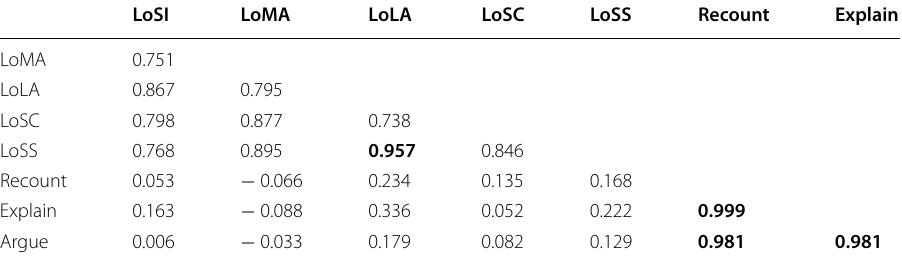
Correlations higher than 0.90 are bolded. The proportion of masters for recount, explain, and argue was 47%, 41%, and 46%. LoSS and LoLA were mastered by 37% and 52%